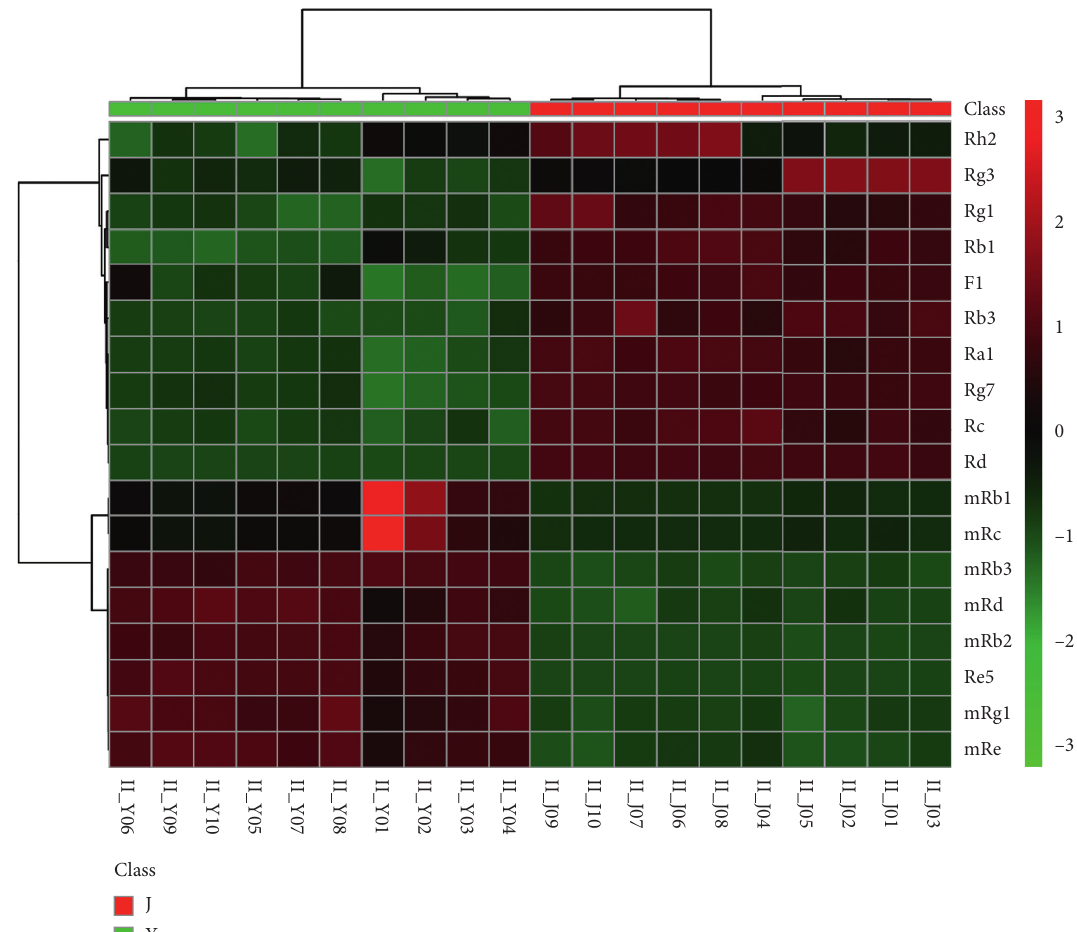
Figure 4: The heat maps visualizing the intensities of the 17 ginsenoside datasets from white ginseng and extruded white ginseng ( n � 10) and extruded white ginseng ( n �